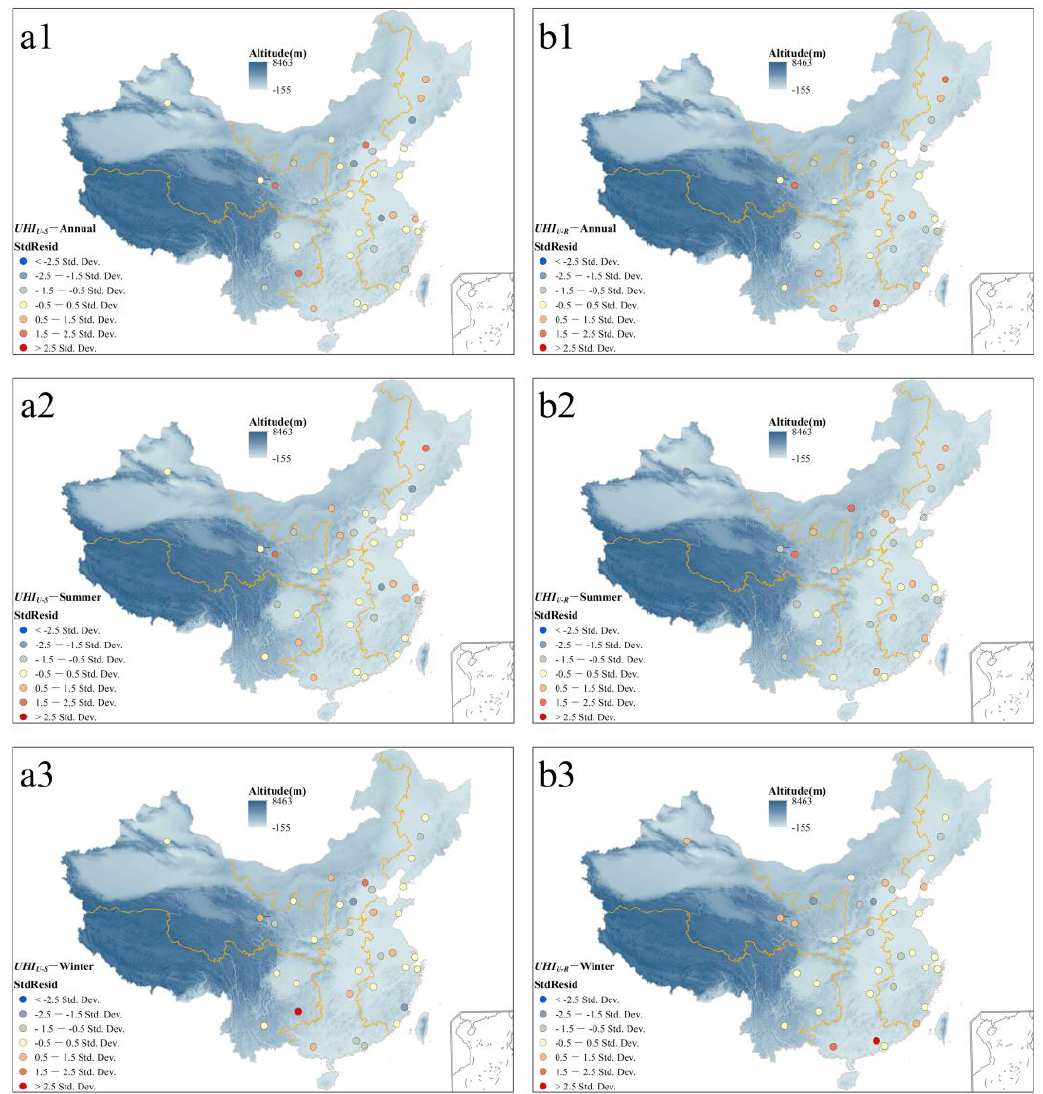
Figure 9. The StdResid distribution output from the OLS model of ( a1 ) annual UHI U − S , ( a2 ) sum- mertime UHI U − S , ( a3 ) wintertime UHI U − S , ( b1 ) annual UHI U − R , ( b2 ) summertime UHI U − R , and ( b3 ) wintertime UHI U − R